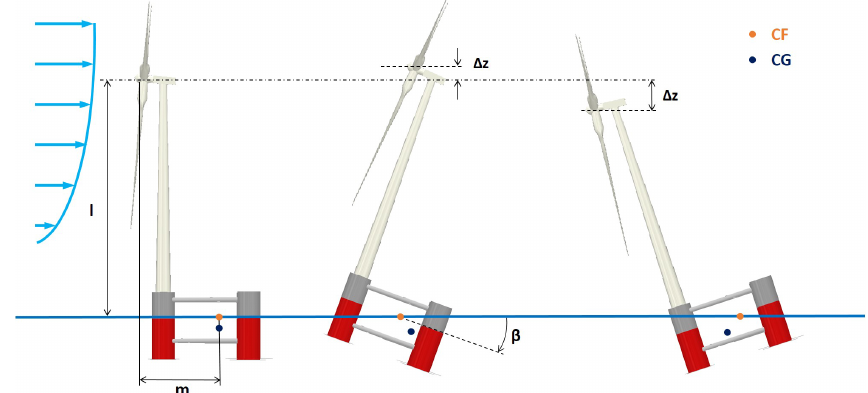
Figure 11. Schematic representation of the effects of platform pitch on rotor hub height, considering Platform A. CF: center of flotation; CG: center of gravity; β : platform pitch